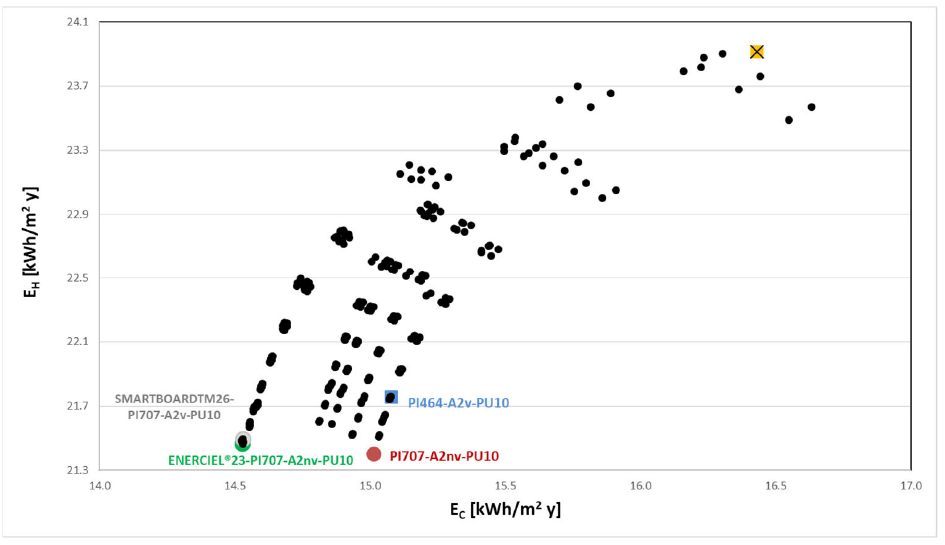
Figure 6. PCMs on inner side: comparison based on heating (E H ) and cooling load (E C ). Instead, starting from the left, there is a first sequence of points starting from the solution ENERCIEL ® 23-PI 707 A 2nv PU 10 , which is characterized by the minimum of the cooling demand (14.5 kWh/m 2 y) and by a heating load of 21.5 kWh/m 2 y. This wall package, compared with BC, allows ∆ E C of − 11.6% and ∆ E H of − 10.2% and it can be considered a profitable solution for improving the performance achievable with an insulated system with low thermal mass. Considering the contribute of the phase change material, the evaluation of the heating and cooling loads reduction compared with the PI 464 A 2v PU 10 indicates that the selected melting temperature contributes to slightly improving the thermal performance with ∆ E C equal to − 3.6%. However, during the winter, the panel allows to increase the utilization of solar gains because it accumulates the energy and release during the day, allowing ∆ E H of − 1.4%. The other points are representative of the same solution but with lower level of insulation until the extreme point ENERCIEL ® 23-PI 0140 A 6v PU 6 , for which E C is 15.9 kWh/m 2 y and E H is 23.7 kWh/m 2 y. This solution is not better than PI 464 A 2v PU 10 because in both seasons the required energy increases; meanwhile, compared with BC, ∆ E C is − 3.3% and ∆ E H is − 1.1%. Thus, it can be concluded that the lower insulation level is not suitable for the considered climate and the PCM is not effective when included in this configuration. Along the same line, there are also the solutions with SmartBoard TM . In this case, the package that minimizes the cooling energy demand is SMARTBOARD TM 26-PI 707 A 2v PU 10 ; E C is 14.5 kWh/m 2 y and E H is 21.5 kWh/m 2 y. With higher melting temperature, the same energy saving compared with BC is achiev- able ( ∆ E C − 11.6%, ∆ E H − 10.1%) for ENERCIEL ® 23-PI 707 A 2nv PU 10 . This happens because the ENERCIEL ® product has the highest h f of all the products examined (73.56 kJ/kg), thanks to the higher percentage of PCM; meanwhile, SmartBoard TM has the higher melting point, 26 ◦ C, which is particularly suitable for combating indoor overheating during the summer months. The other products provide less benefit, and the simulation results occupy the other branches of the graph. For instance, with the same insulation level, the solution WEBER.MUR CLIMA ® 23-PI 707 A 2nv PU 10 is characterized by E C of 15.0 kWh/m 2 y and E H of 21.5 kWh/m 2 y.